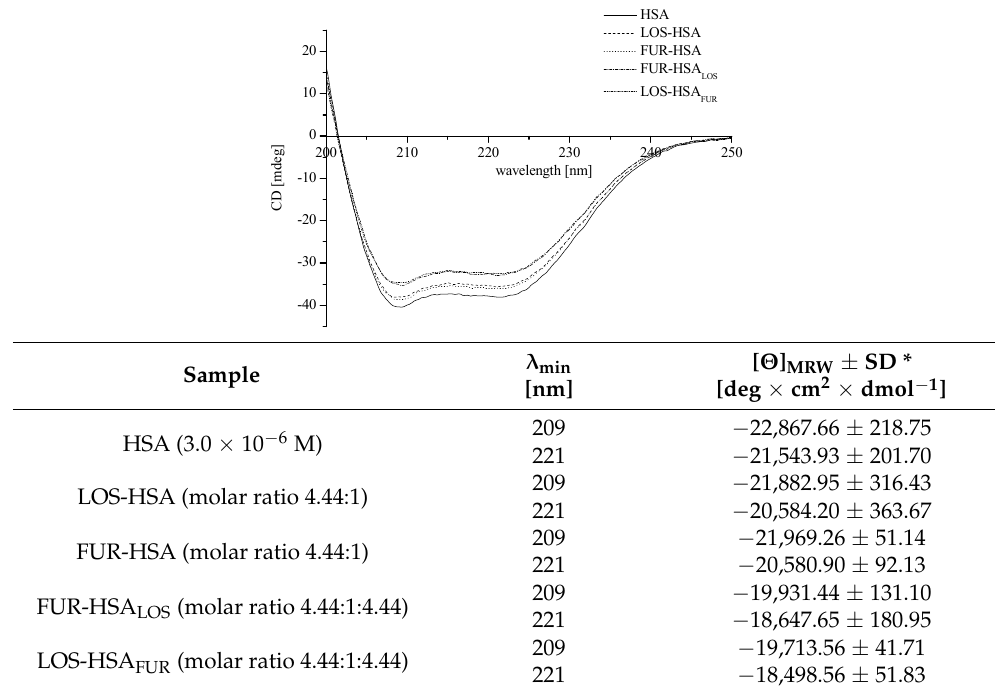
Table 4. The percentage (%) content of HSA secondary structure elements in the sample without drugs (HSA) and in the presence of drugs, in the binary LOS-HSA and FUR-HSA and ternary FUR-HSA LOS and LOS-HSA FUR systems (Yang’s reference model).